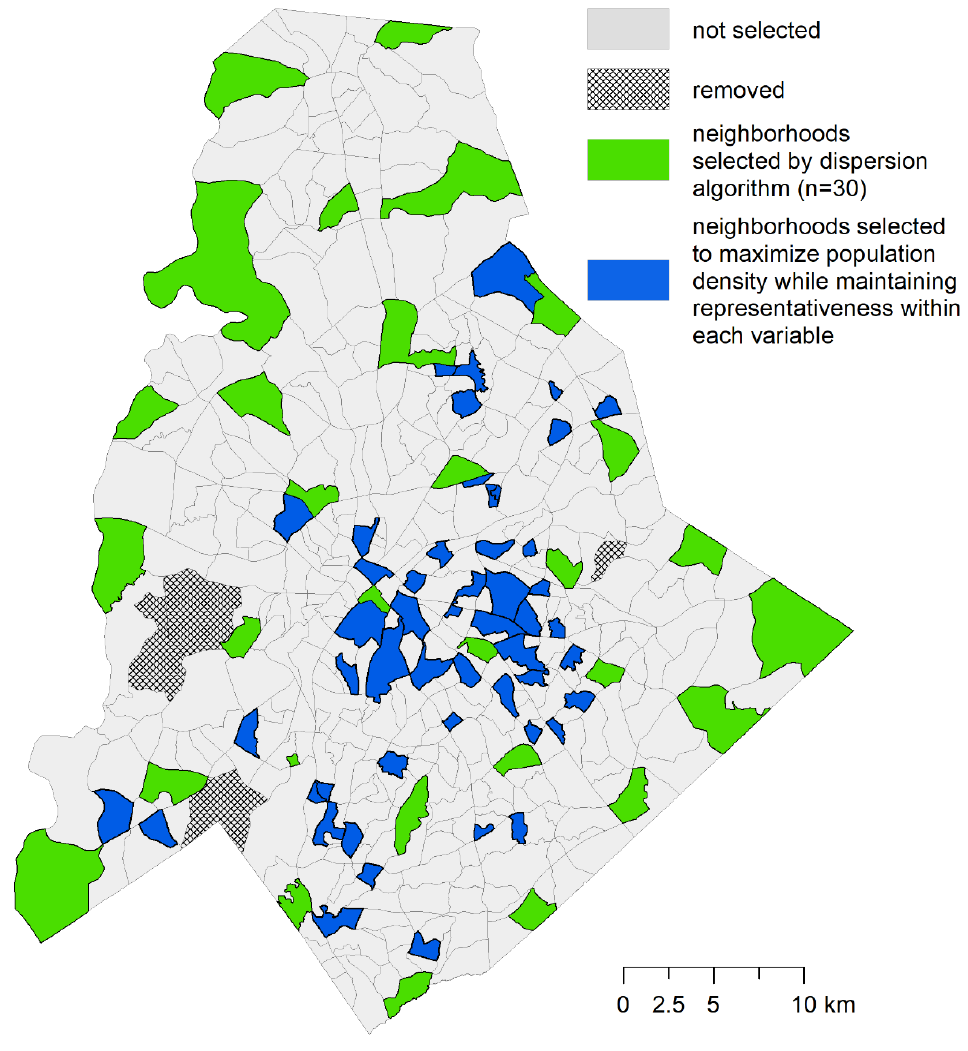
Table 2. Results from the Kolmogorov-Smirnov test comparing the distribution of the nine variables with exhaustive and optimized sample, respectively. The p-value indicates the significance level.